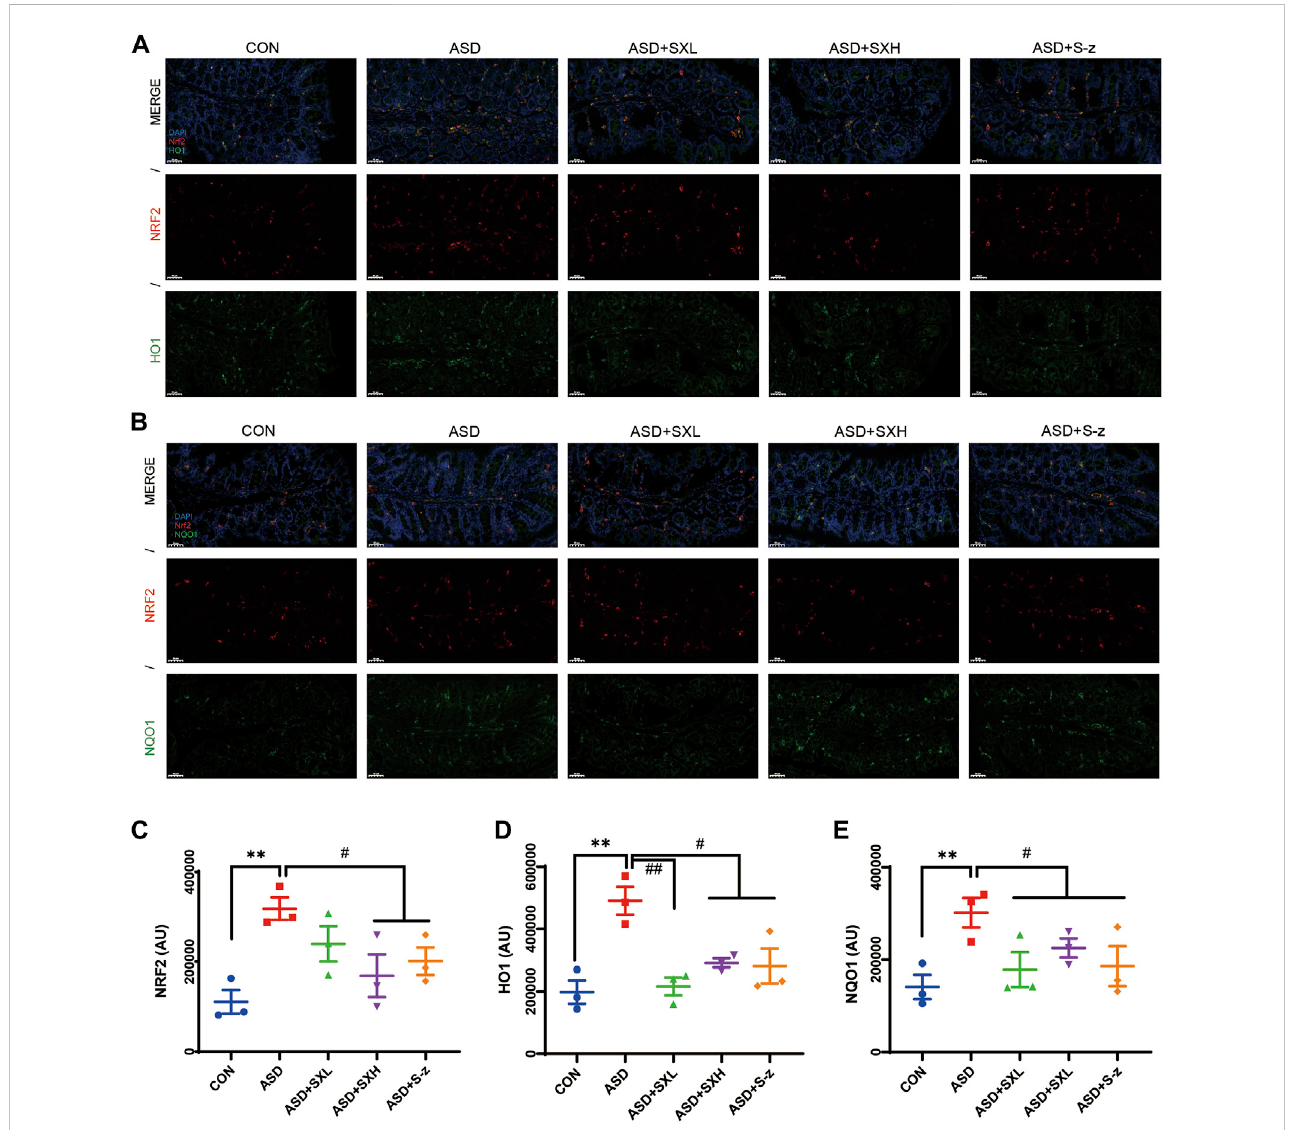
FIGURE 6 Immuno fl uorescence analysis of NRF2 (red), HO1 and NQO1 (green) in colon mucosal layers (×400 magni fi cation). (A) Representative fl uorescence confocal images show NRF2 and HO1 staining in the colon sections of mice belonging to the CON, ASD, ASD + SXL, ASD + SXH, and ASD + S-z groups. The nucleiwerestainedwithDAPI(blue). (B) Representative fl uorescenceconfocalimagesshowNRF2andNQO1staininginthecolonsectionsofmicebelonging totheCON,ASD,ASD+SXL,ASD+SXH,andASD+S-zgroups.ThenucleiwerestainedwithDAPI(blue). (C) QuantitativeanalysisofNRF2 fl uorescence. (D) Quantitative analysis of HO1 fl uorescence. (E) Quantitative analysis of NQO1 fl uorescence. The immuno fl uorescence signal intensity in the images was quanti fi ed using the ImageJ software. n = 3 per group. The experiment was repeated three times. The data are shown as mean ± S.E.M. ** p < 0.01 vs. CON group; # p < 0.05, ## p < 0.01 vs. ASD group. Scale bar: 50 μ